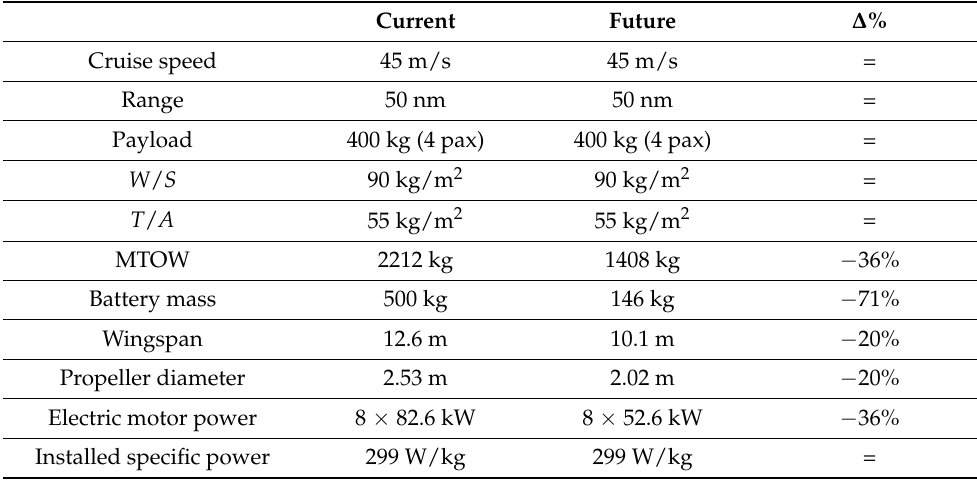
Table 13. Comparison of two TiltOne configurations with same T / A (55 kg/m 2 ) and W / S (90 kg/m 2 ) and different technological